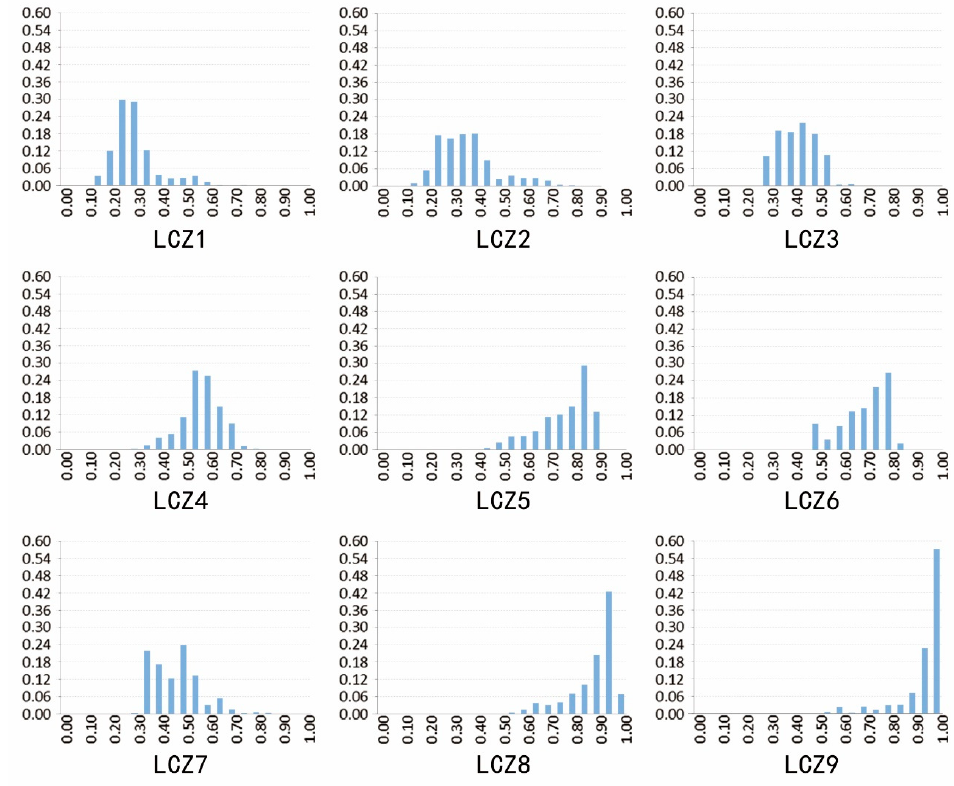
Figure 4. Statistical distribution of SVF for all the nine models.